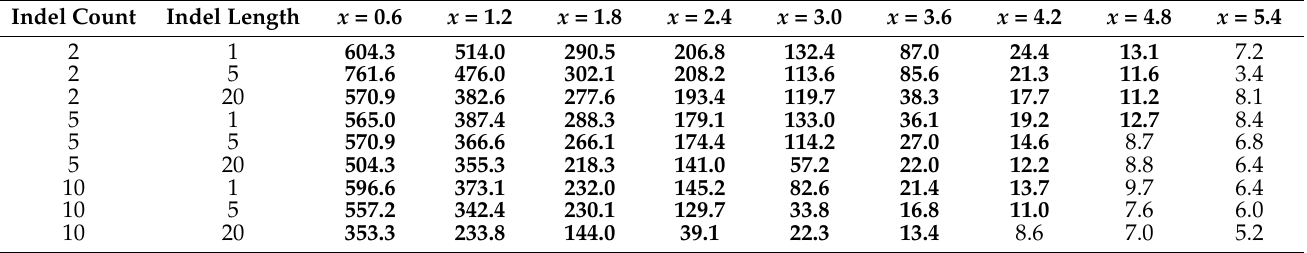
Table 3. Z values for multiple alignments of 81 Des sets built using MAHDS ( Z values > 10.0 are in bold). Indel Count